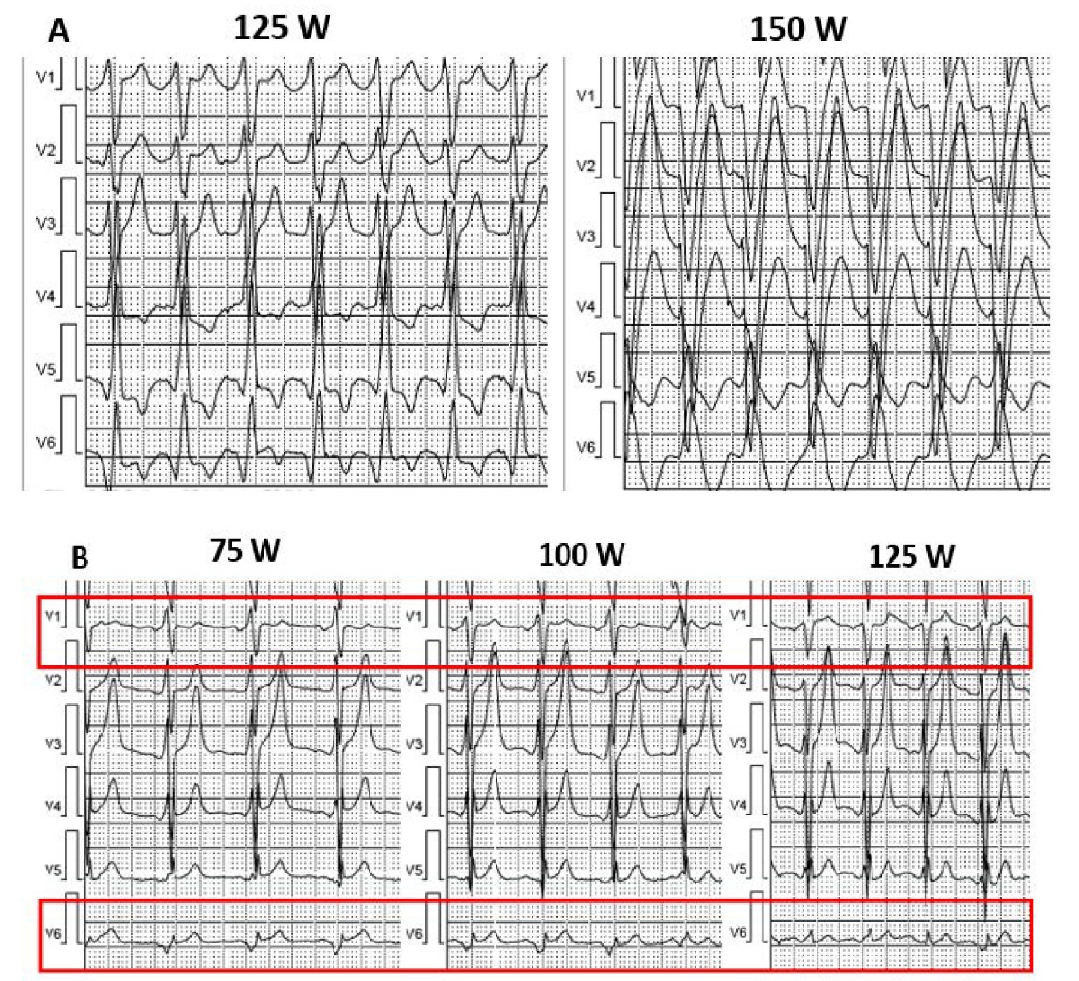
Figure 1. ( A ) Fusion pacing at 125 W: note the thin QRS complexes with r wave in V1 and q wave in V6. Complete loss of LV capture at 150 W: larger QRS with typical LBBB morphology. ( B ) Incomplete loss of capture: during exercise, a progressive loss of R wave in V1, V2, and q wave in V6 can be noted.